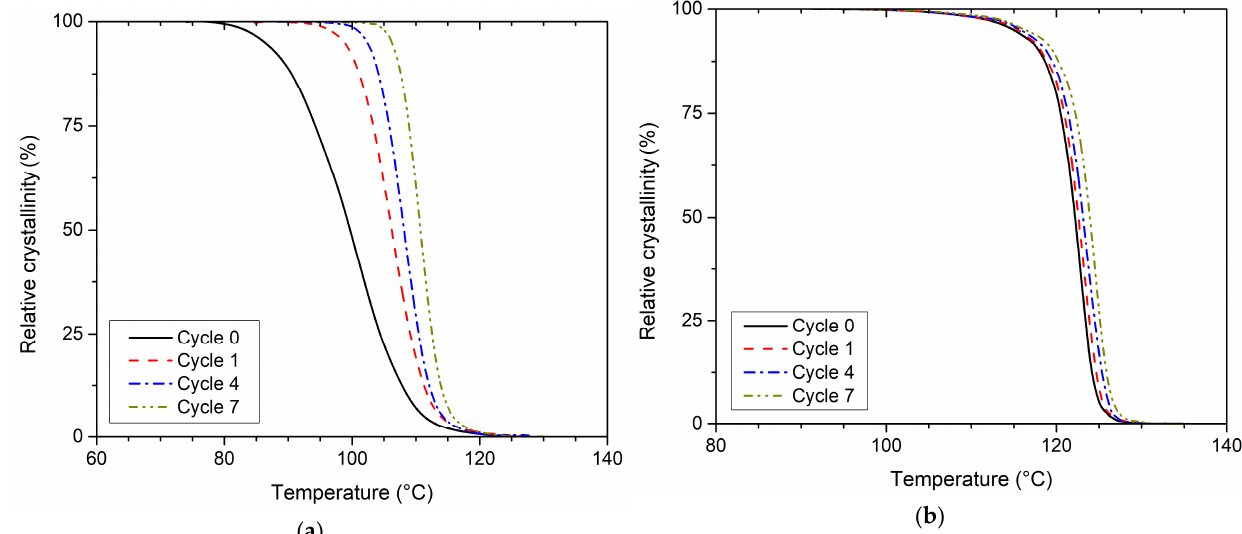
Figure 7. Relative crystallinity versus temperature for non-isothermal crystallisation ( a ) PLLA and ( b ) PHBV—cumulative crystallisation curves.